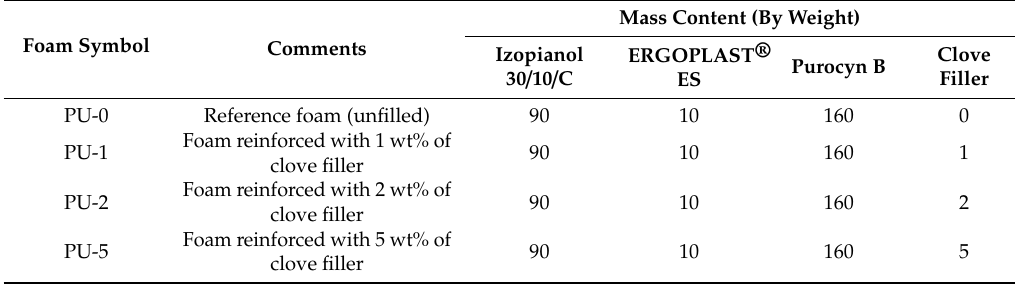
Table 1. Foam formulations.